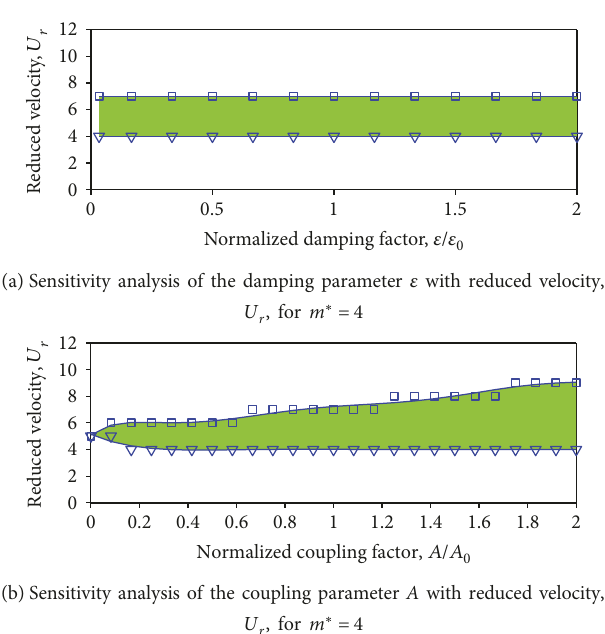
Figure 11: Sensitivity of the VIV model of a circular cylinder by [32] to parameter values. Lock-in region: □ , upper boundary; ∇ , lower boundary; lock-in region (in green).